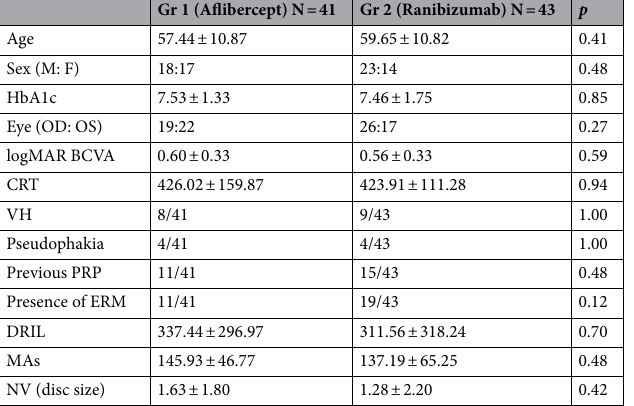
Table 1. Baseline characteristics. Gr group, M male, F female, OD right eye, OS left eye, logMAR BCVA best- corrected visual acuity in the logarithm of the minimal angle of resolution, CRT central retinal thickness, VH vitreous hemorrhage, PRP panretinal photocoagulation, ERM epiretinal membrane, DRIL Disorganization of the retinal inner layers, MAs microaneurysms, NV retinal